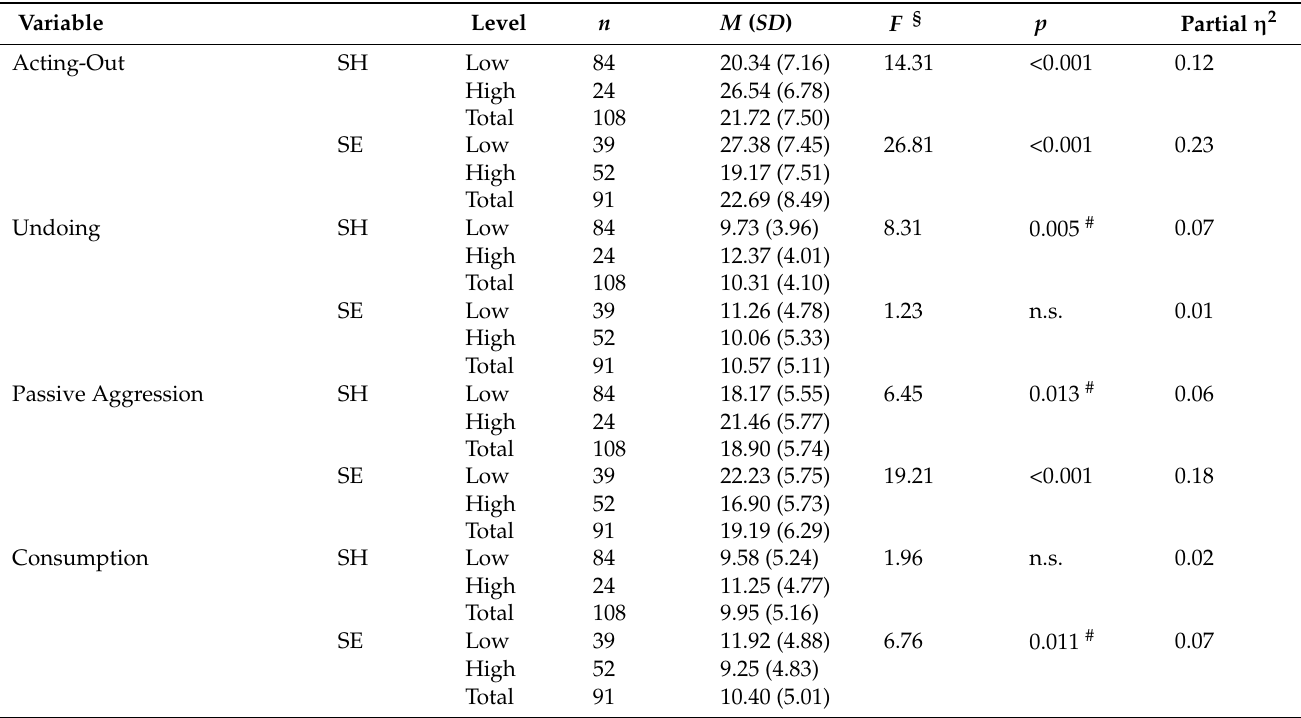
Table 4. Follow-up ANOVAs. DSQ scales by low and high Studyholism (SH) and Study Engagement (SE). Maladaptive